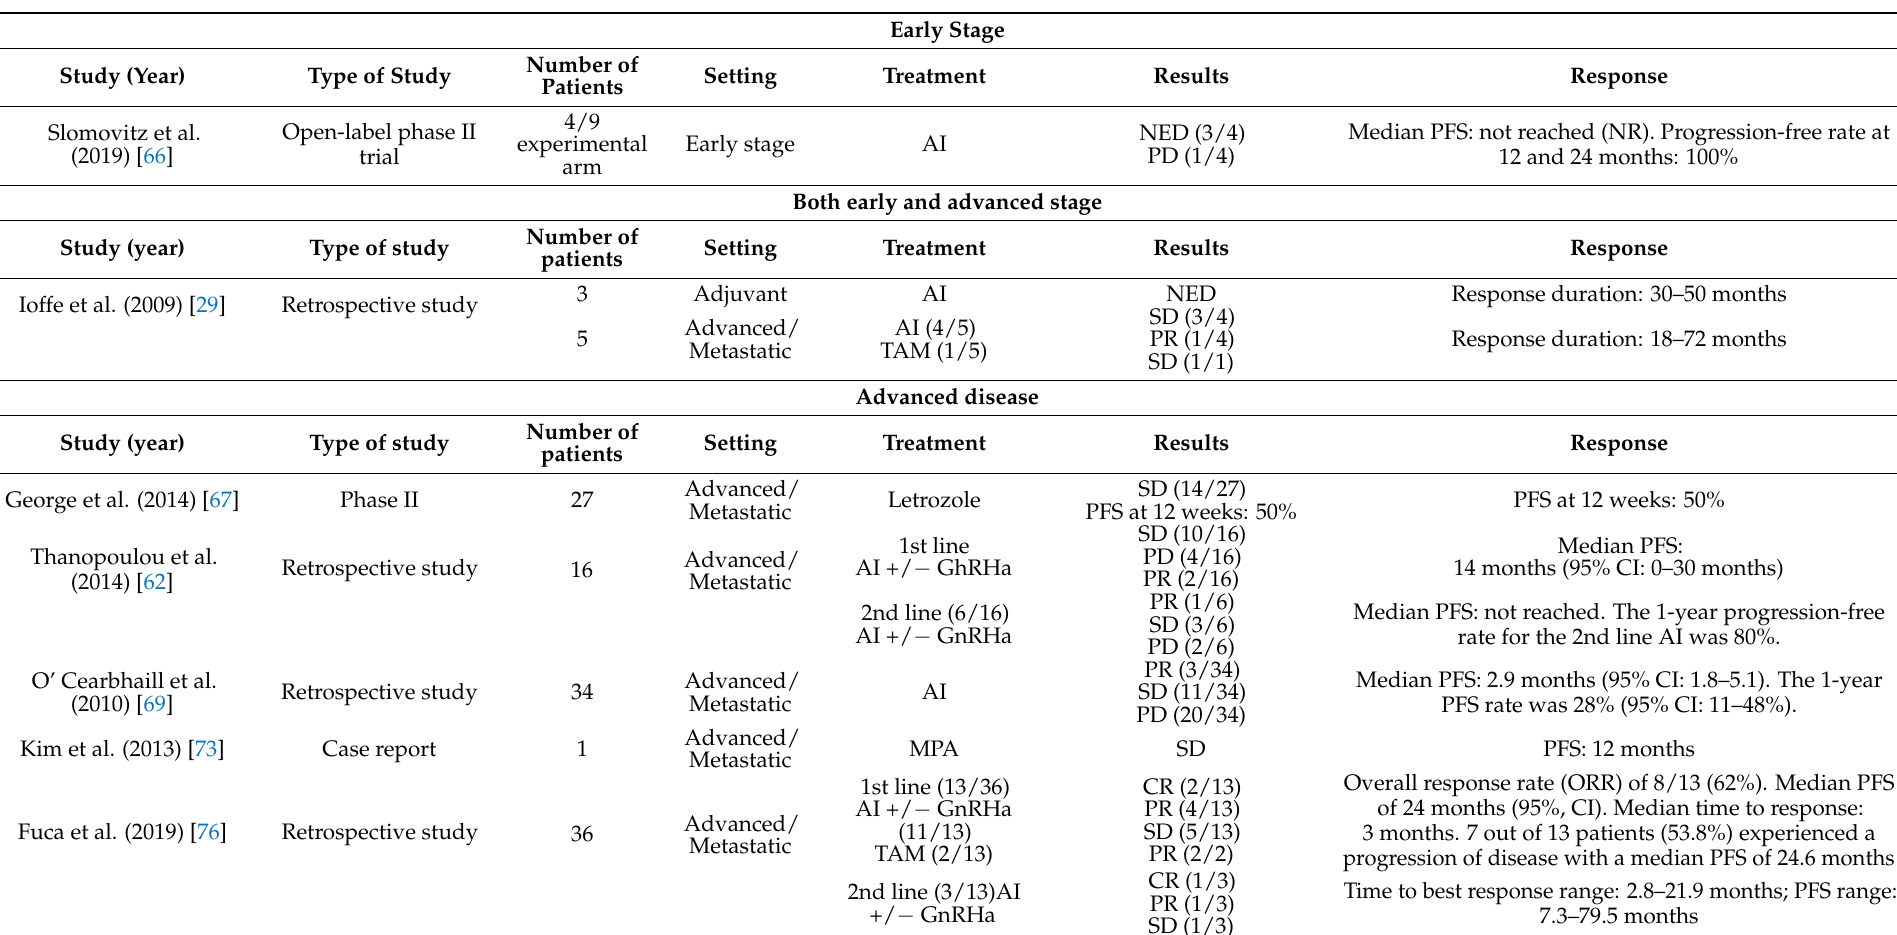
Table 2. Summary of data upon hormonal therapy used for the treatment of uLMS and aggressive